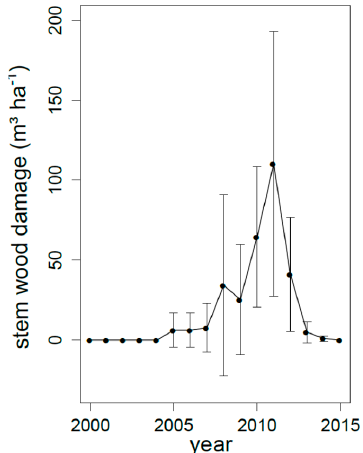
Figure 2. Wind throw and spruce bark beetle disturbance in the Kalkalpen National Park between 2000 and 2015. and